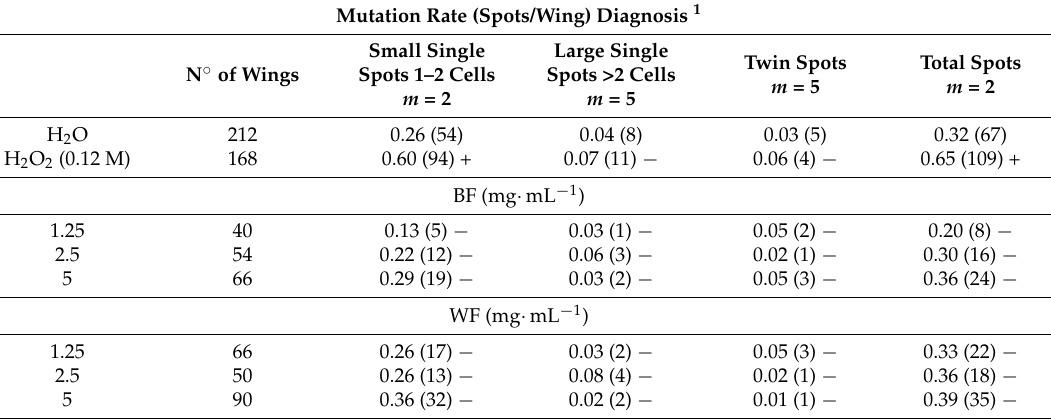
Table 2. Genotoxicity of Borago officinalis plant material: blue flowered (BF) and white flowered (WF); and the bioactive compounds: rosmarinic (RO), syringic (SY) and sinapic (SI)